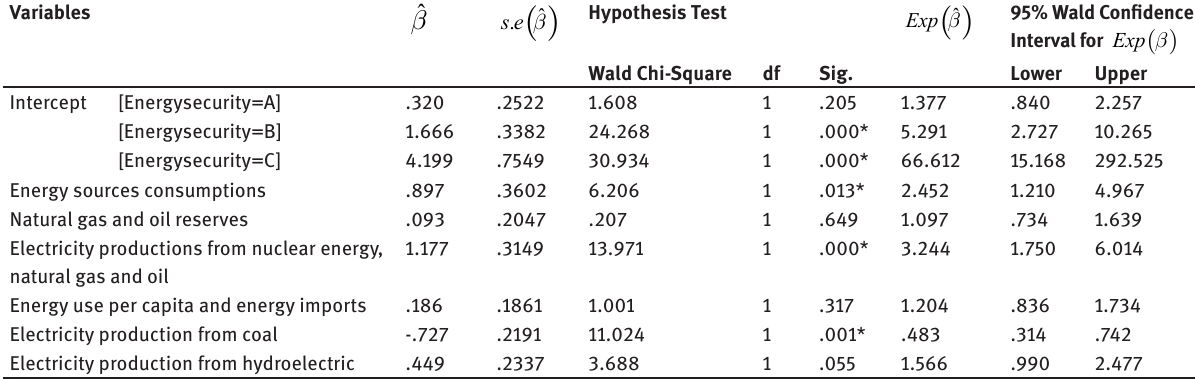
Table 7: Results for GLM by using ML method with hybrid iterative algorithm under cumulative complementary log-log link function.